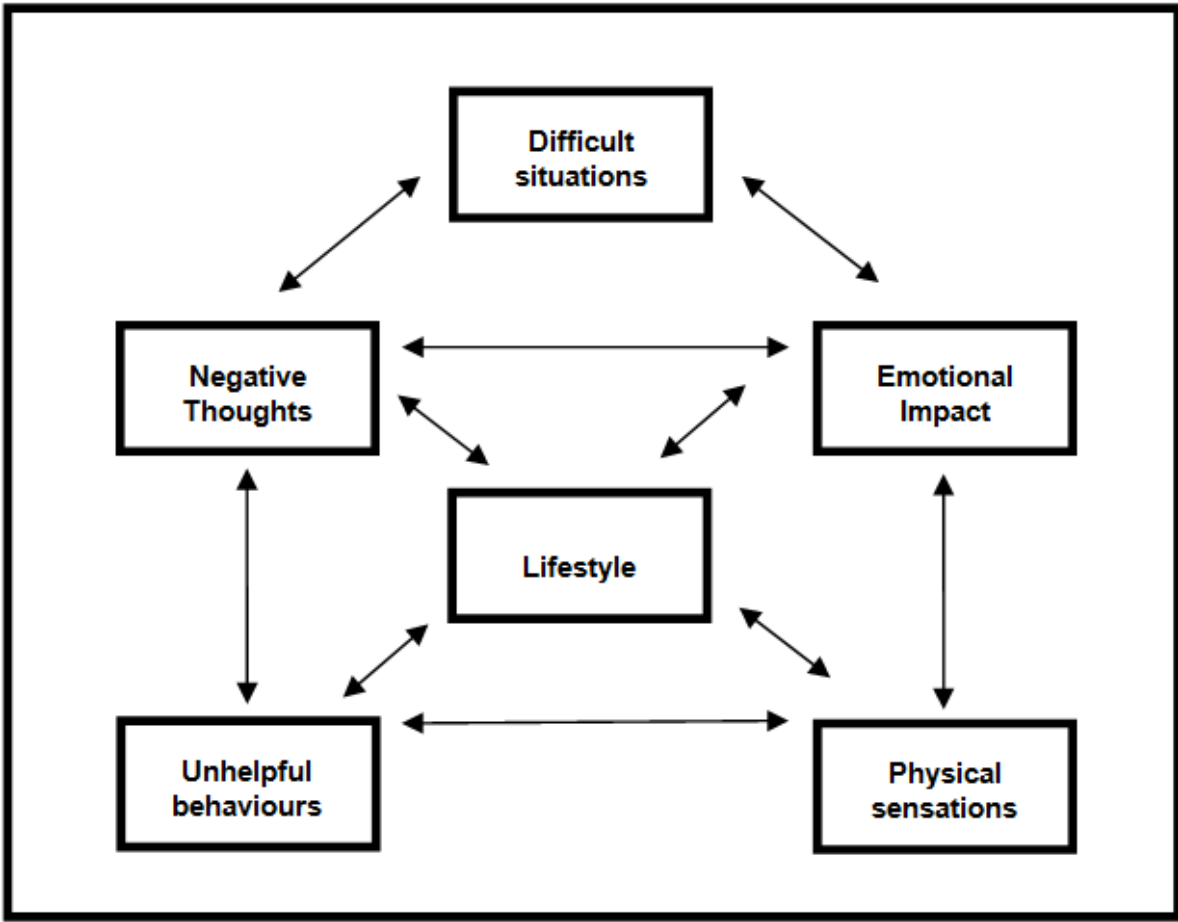
Figure 1. Domains of functioning contained within the